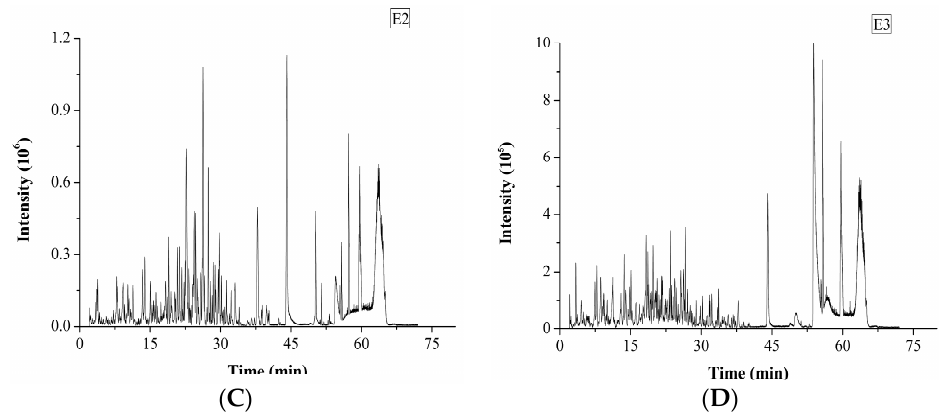
Figure 3. Tricine-SDS-PAGE analysis and Base Peak Chromatogram spectrum of enzymatic hydrolysates of M. edulis protein fractions were shown. ( A ) The peptides were electrophoresed on 4% stacking gel and 16% separating gel. ( B – D ) Enzymatic hydrolysis products in samples E1, E2 and E3 correspond to the hydrolysates of P1–P3 respectively and base Peak Chromatogram spectrum of enzymatic hydrolysates of M. edulis protein fractions.